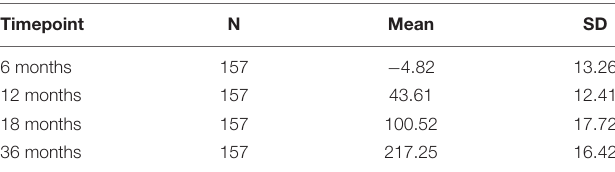
TABLE 5 | Results of the linear mixed-effect regression analysis of cognitive developmental trajectories.